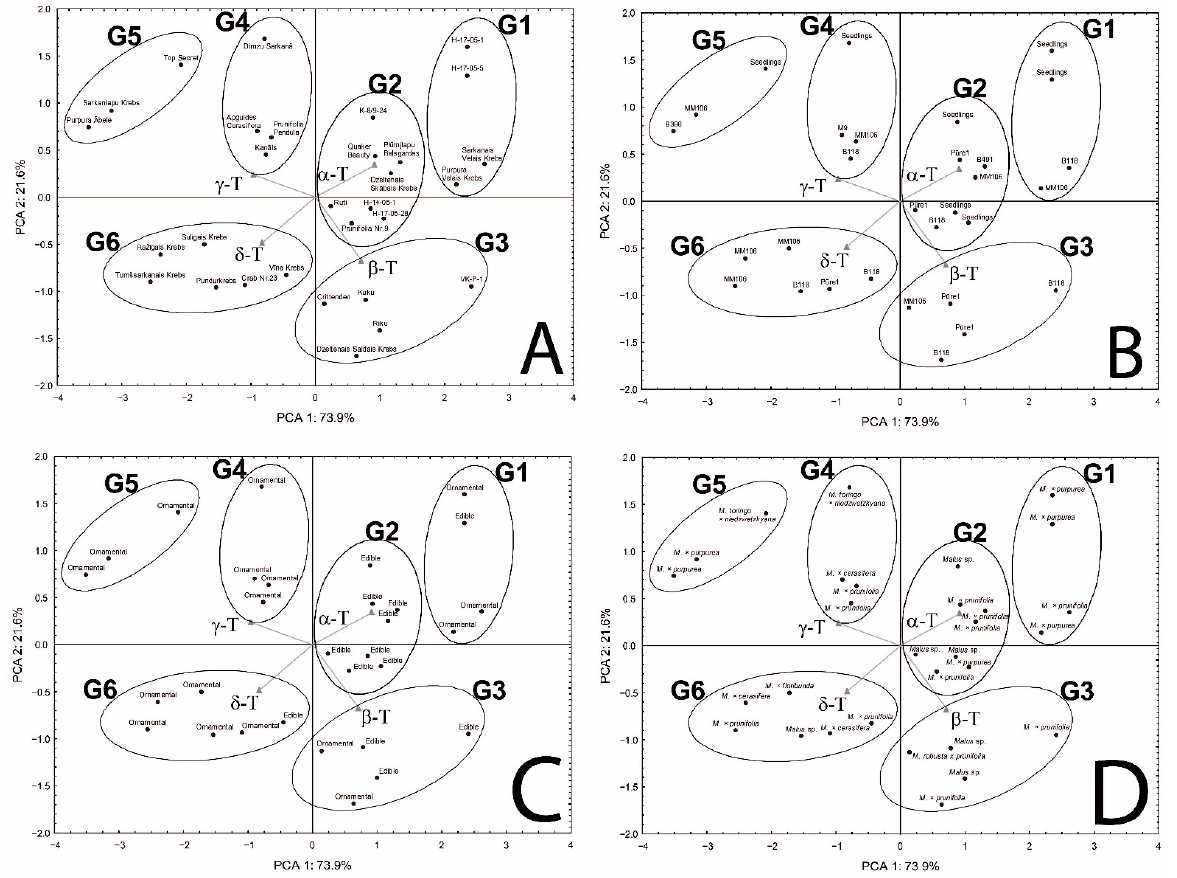
Figure 3. Distribution of study samples based on the principal component analysis (PCA) according to content proportions of tocopherol homologues ( α , β , γ , and δ ) (%) with different indicators: genotype ( A ), rootstock ( B ), purposes of crab apples (ornamental and edible) ( C ), and species ( D ).